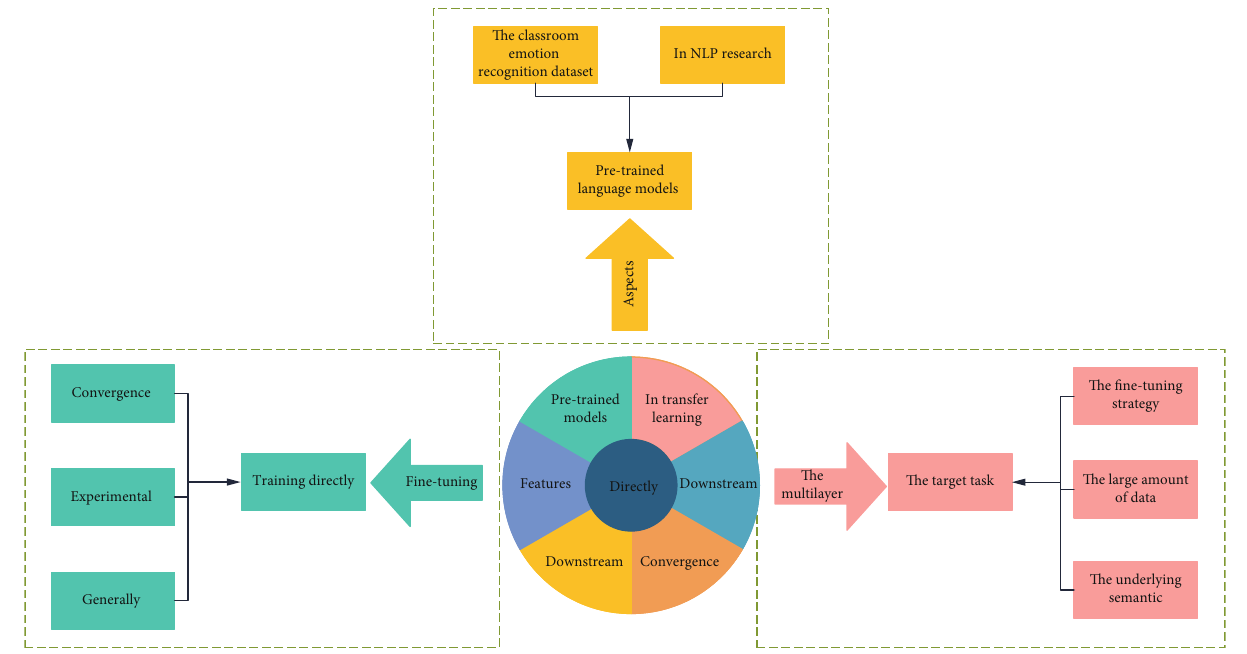
Figure 4: Pretraining model fi ne-tuning